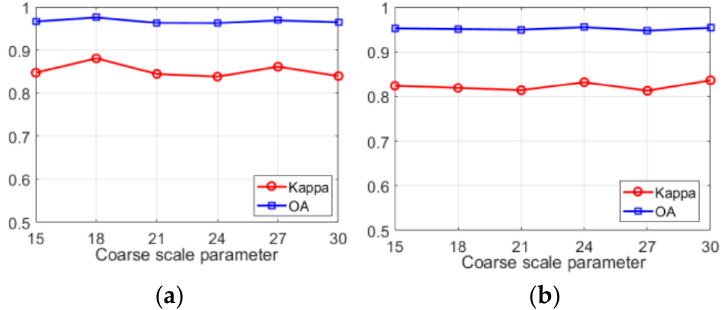
Figure 16. Kappa and OA under different